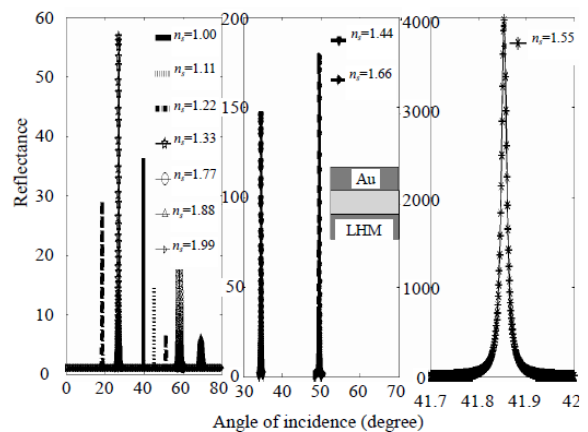
Fig. 4 Simulated SPR curves with different refractive indexes of the sensing layer (thickness 360 nm ) stacked between left-handed materials (LHM), (refractive index{  LHM ,  LHM } = {–33.5, –11}, thickness 720 nm) and the Au layer (refractive index ε Au = –21.3+1.34i).